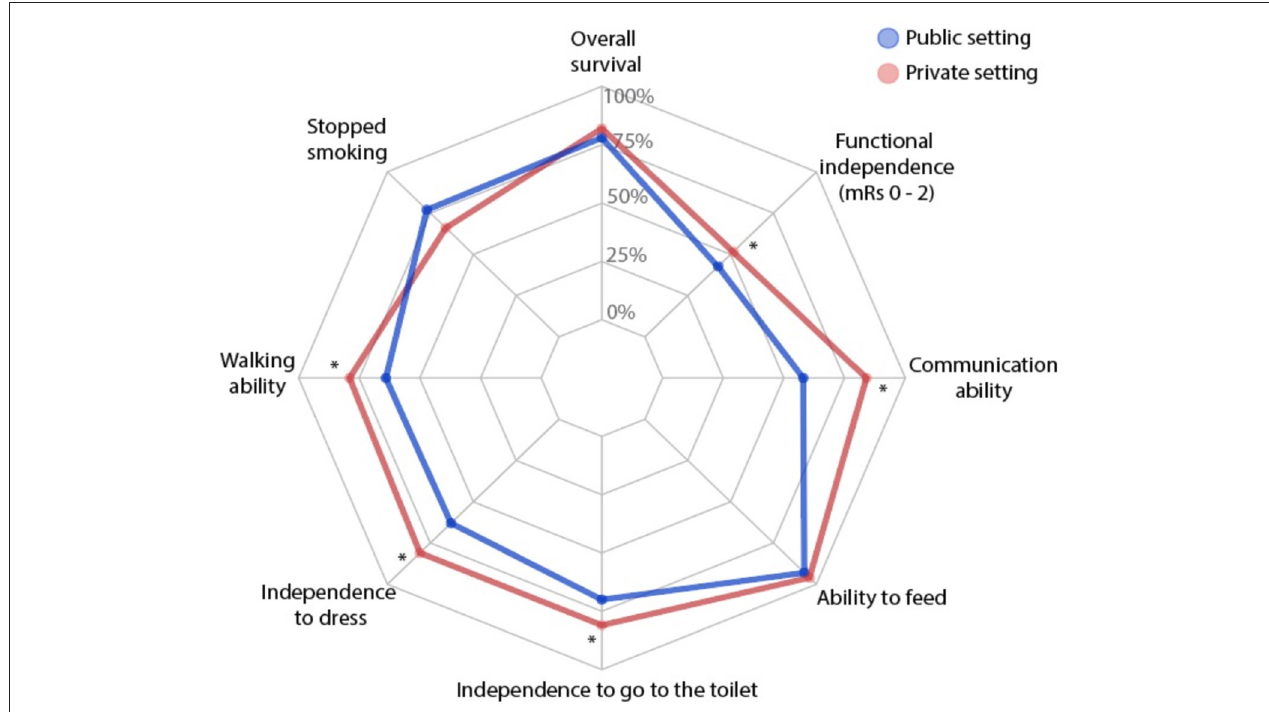
FIGURE 2 | Patient-reported outcomes measurement of post-stroke patients in a public (blue) and a private (red) settings. The external line represents 100% of patients with good outcomes in each domain. * p < 0.05.